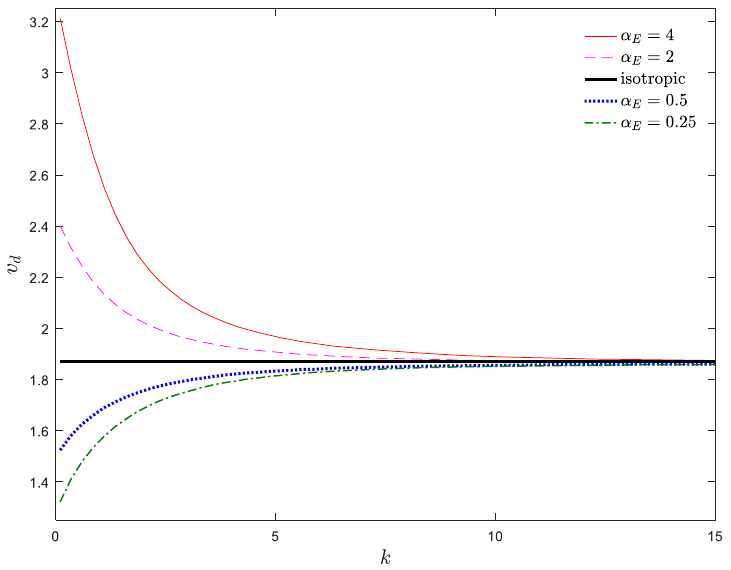
Figure 8. Dimensionless critical velocity of the system against power index for ζ = 0, α ρ = 1, µ = 0, k f = 0.5.